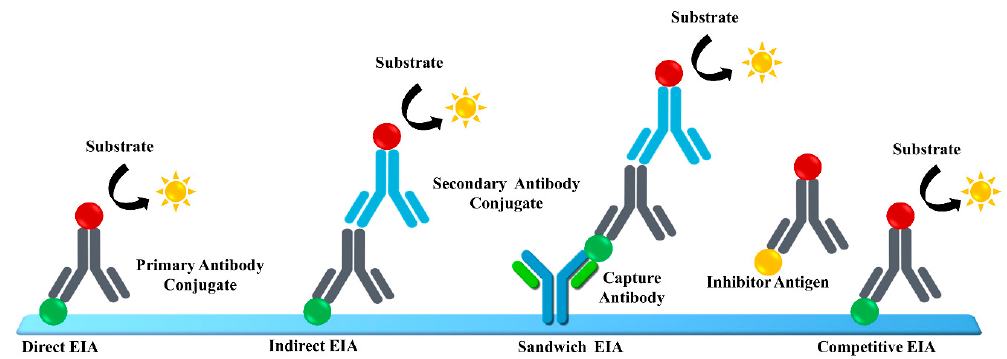
Figure 6. Methods for the detection of anti-HCV antibodies using enzyme immunoassays.